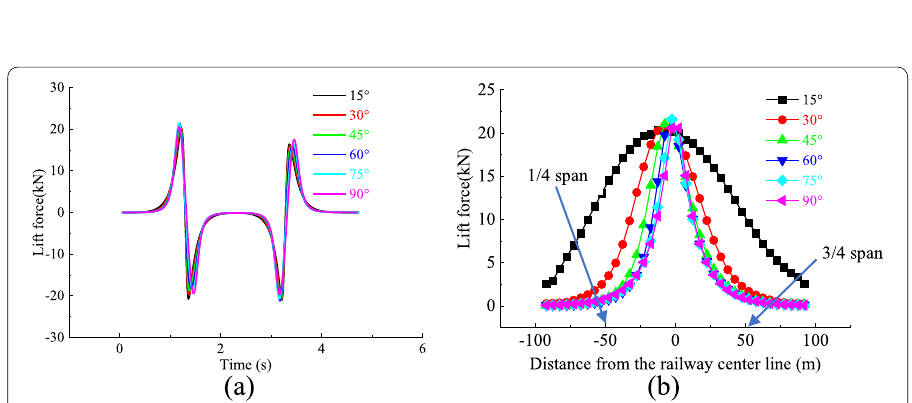
Fig. 9 Effects of angle of intersection: a lift force time history curve; b attenuation curve of positive lift force of head wave along longitudinal bridge